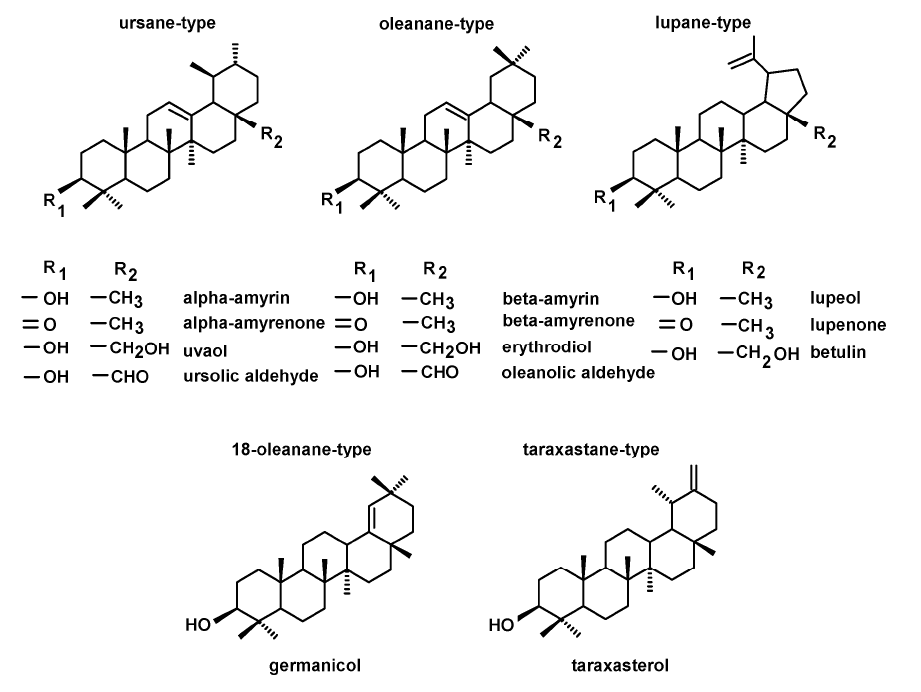
Figure 2. The structures of identified neutral triterpenoids.